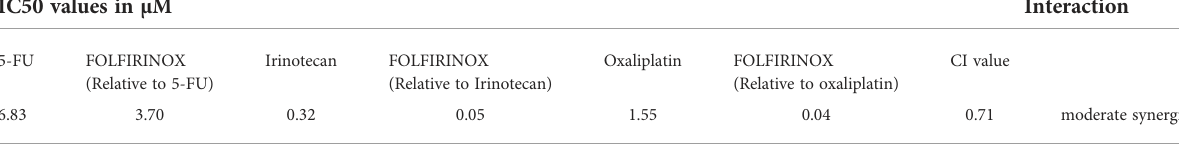
TABLE 3 Drug interaction of FOLFIRINOX.